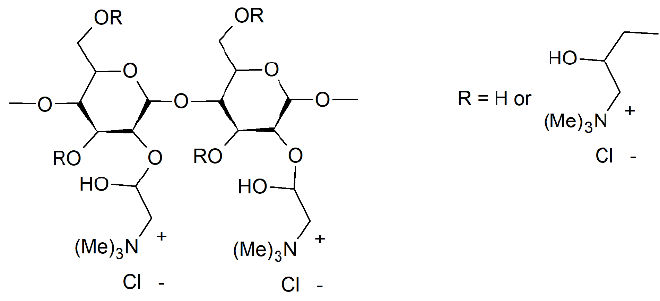
Figure 6. Example of cationic functionalized starch.